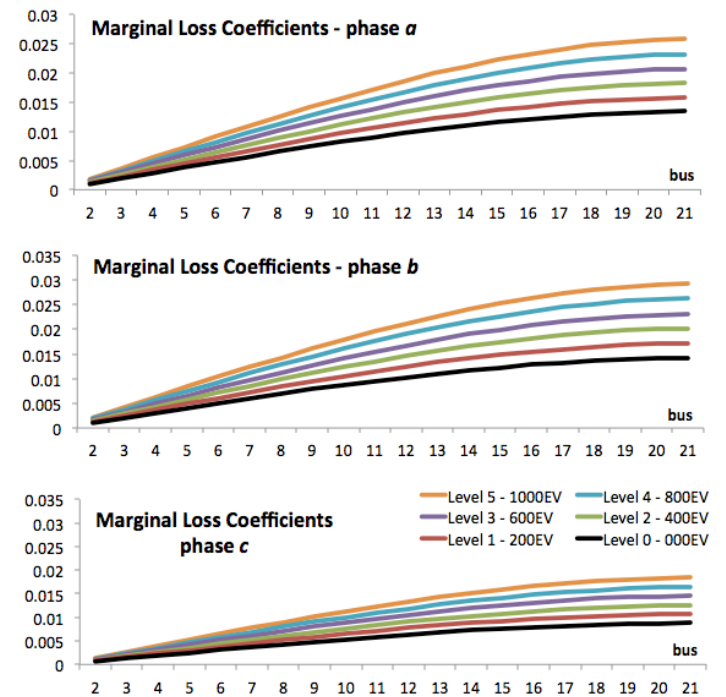
Figure 11. Peak load scenario: MLCs at 20:00 by EV penetration level and by